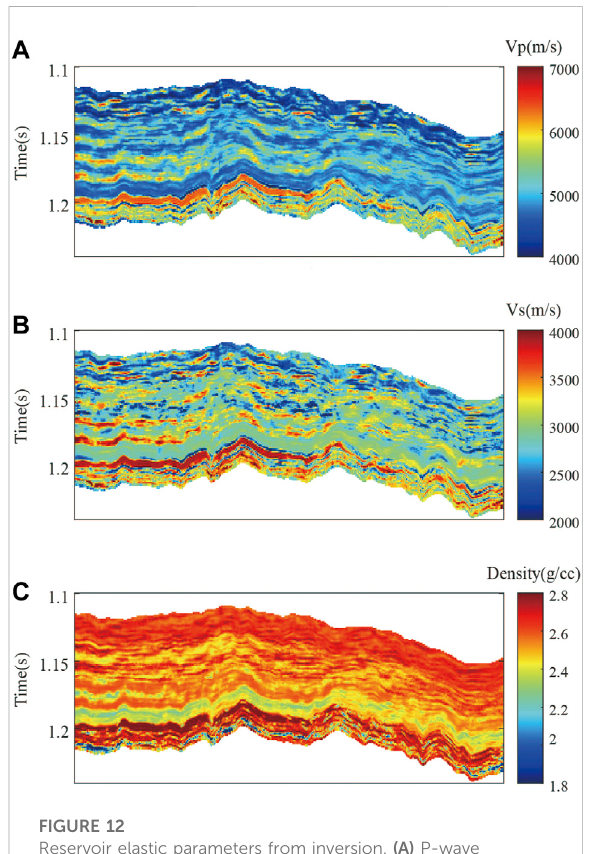
FIGURE 12 Reservoir elastic parameters from inversion. (A) P-wave velocity, (B) S-wave velocity, (C)